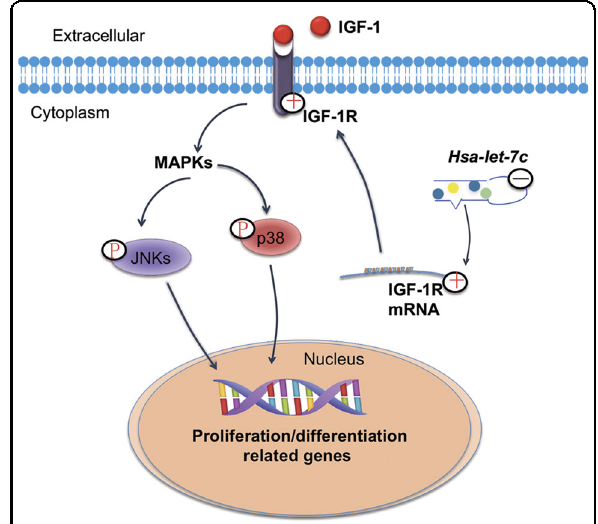
Fig. 7 Schematic diagram of the let-7c /IGF-1/IGF-1R/MAPK axis in DPMSCs. In our model of the let-7c /IGF-1/IGF-1R/MAPK axis, IGF-1R can bind to its ligand IGF-1 and regulate DPMSC proliferation/ differentiation via MAPK signaling pathways. Hsa-let-7c can bind to the IGF-1R 3 ′ -UTR and inhibit the expression of IGF-1R mRNA, thereby suppressing IGF-1-induced proliferation/differentiation in